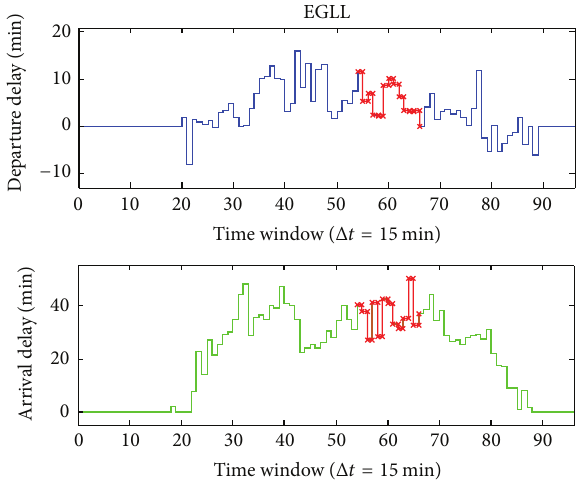
Figure 8: Actual delay profile of EGLL on June 02,